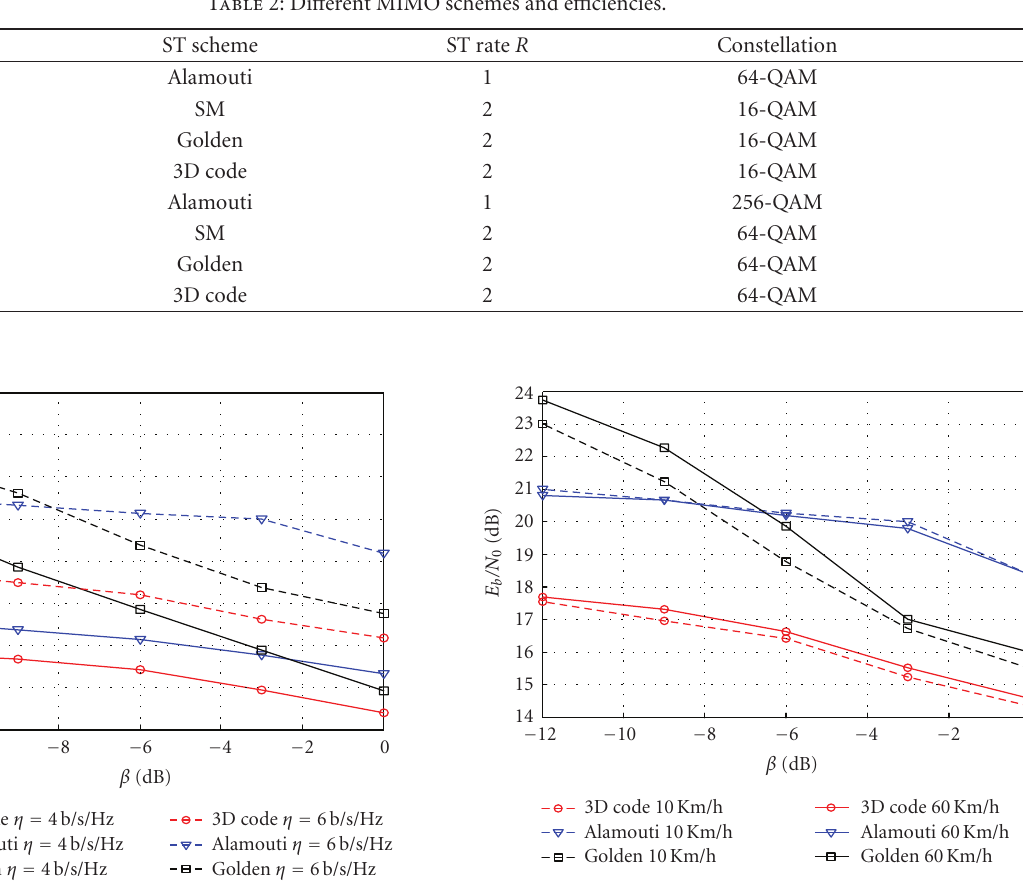
Figure 9: Required E b /N 0 to obtain a BER = 10 − 4 , η = 6b/s/Hz, TU-6 channel, di ff erent values of MT